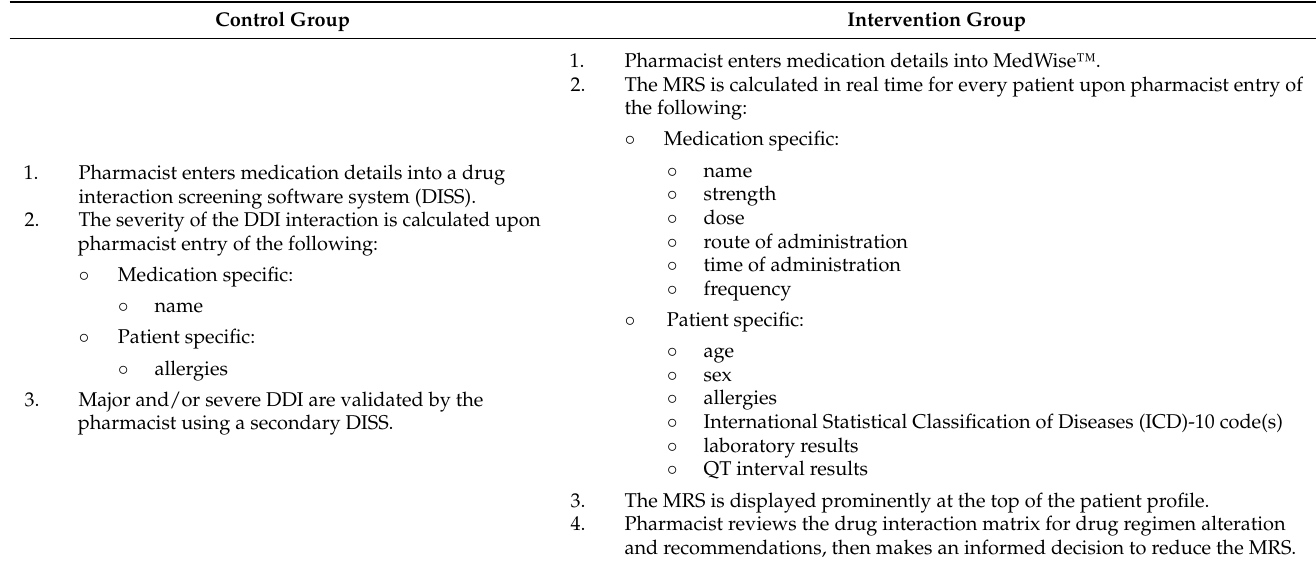
Table 1. Description of MRP assessments in intervention and control